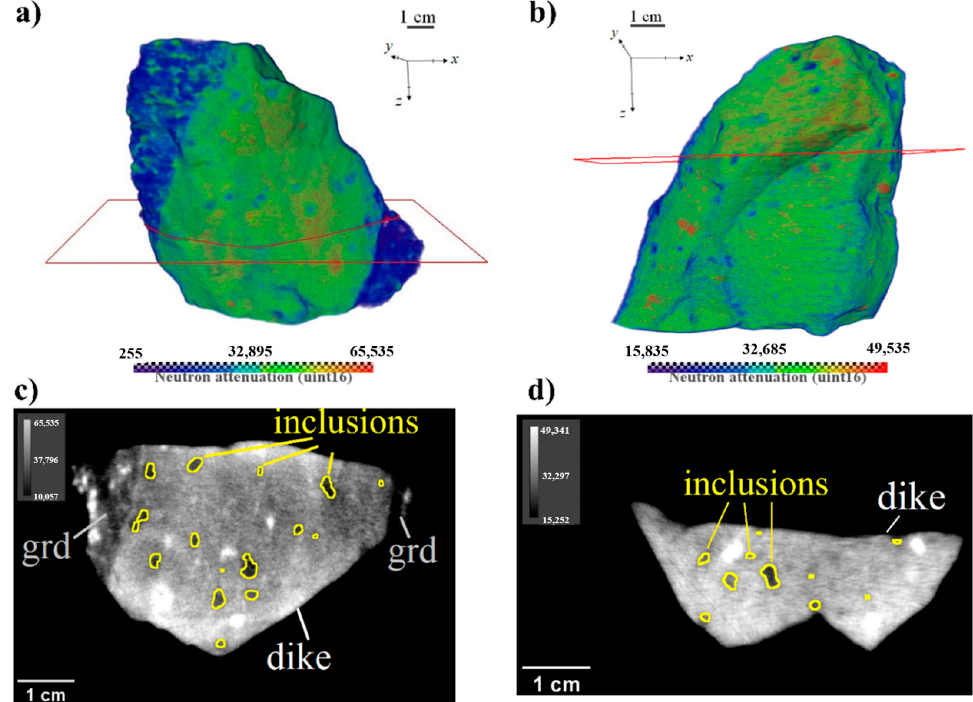
Figure 3. Reconstructed virtual models of the studied dike samples: the upper row—3D models; the lower row—selected 2D slices (‘grd’—granodiorite). ( a , c )—Sample_1; ( b , d )—Sample_2. The spatial positions of the slices on the three-dimensional model are marked. Color bars show the variation of neutron attenuation coefficient values converted to 16-bit integers.